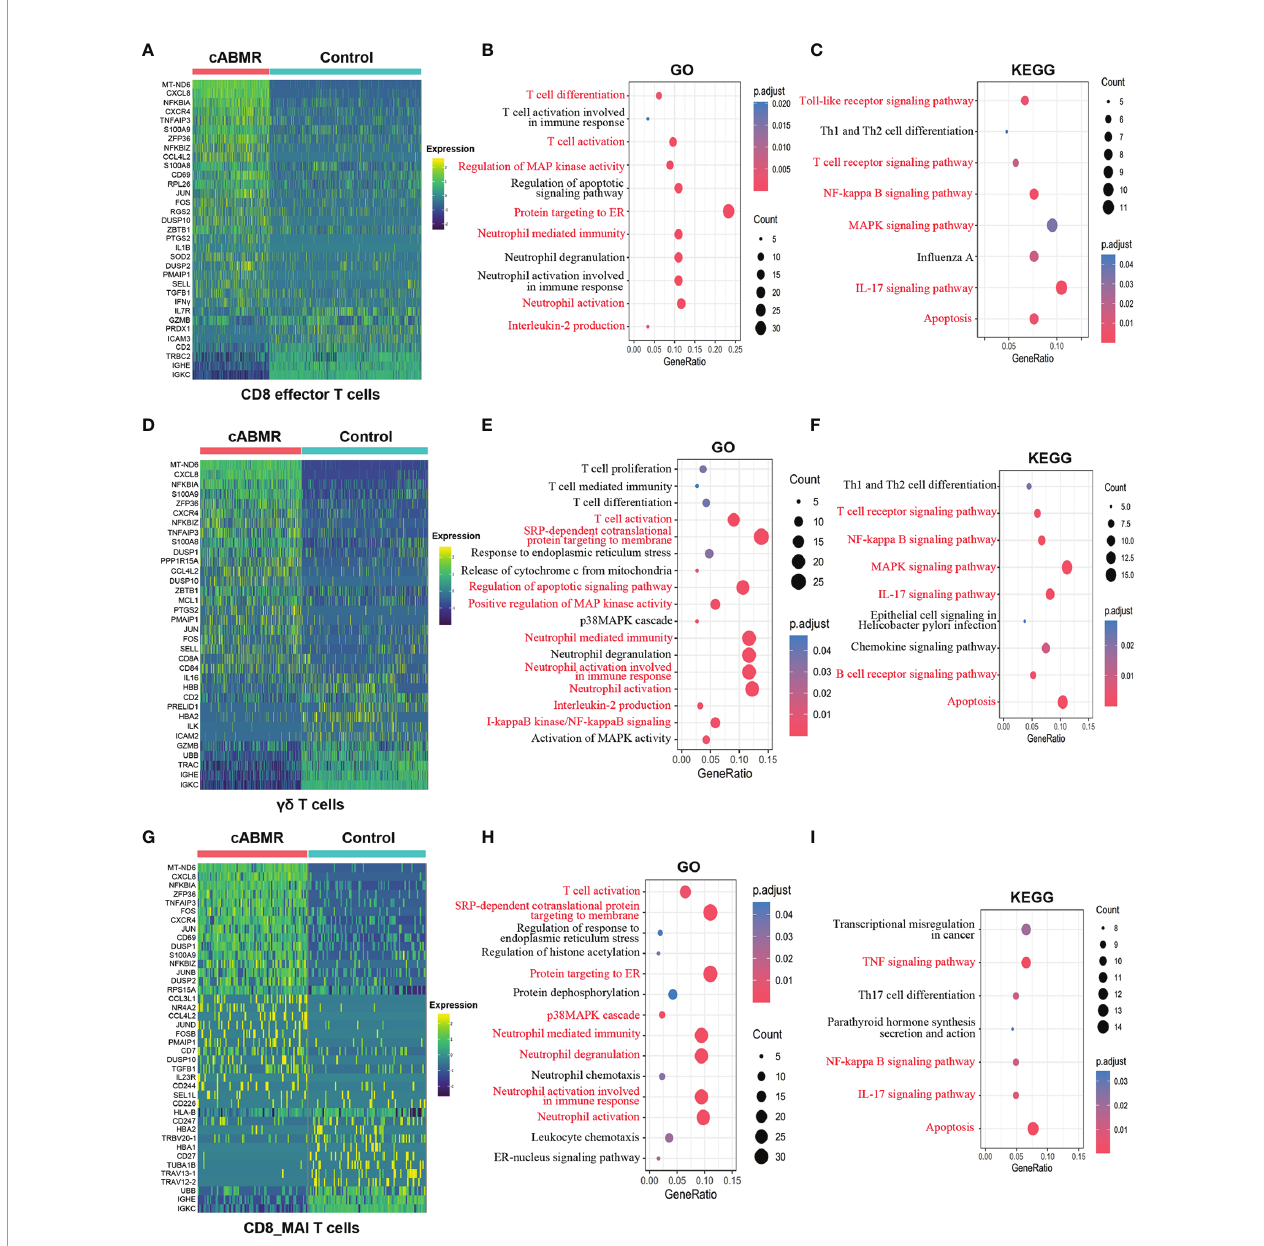
FIGURE 4 | Differential genes expression, GO and KEGG enrichment analysis in T cell subsets. (A) Heat map of differential genes expression in CD8 effector T cells between control and cABMR group. Each column represents a group, and each row corresponds to a marker gene for each group; differential genes expression were fi ltered using a minimum log(fold change) of 0.25 and a maximum adjusted p value of 0.05 and were then ranked by average log(fold change) and FDR. (B, C) The GO (B) and KEGG (C) enrichment analysis of CD8 effector T cells between control and cABMR group; GO and KEGG terms are labeled with name and sorted by − log 10 (P) value. A darker red indicates a smaller P value. The node size indicates the number of genes enriched. Interesting terms are labeled in red. (D) Heat map of differential genes expression in gd T cells between control and cABMR group; (E, F) The GO (E) and KEGG (F) enrichment analysis of gd T cells between control and cABMR group; (G) Heat map of differential genes expression in CD8_MAI T cells between control and cABMR group; (H, I) The GO (H) and KEGG (I) enrichment analysis of CD8_MAI T cells between control and cABMR group. GO and KEGG enrichment analysis revealed DEGs were mainly enriched in some biological processes and pathways in endothelial cells and glomerular endothelial cells respectively. Abbreviations were as follows: pct.exp, percentage of cells expressing gene; count, number of genes annotated to GO terms or KEGG